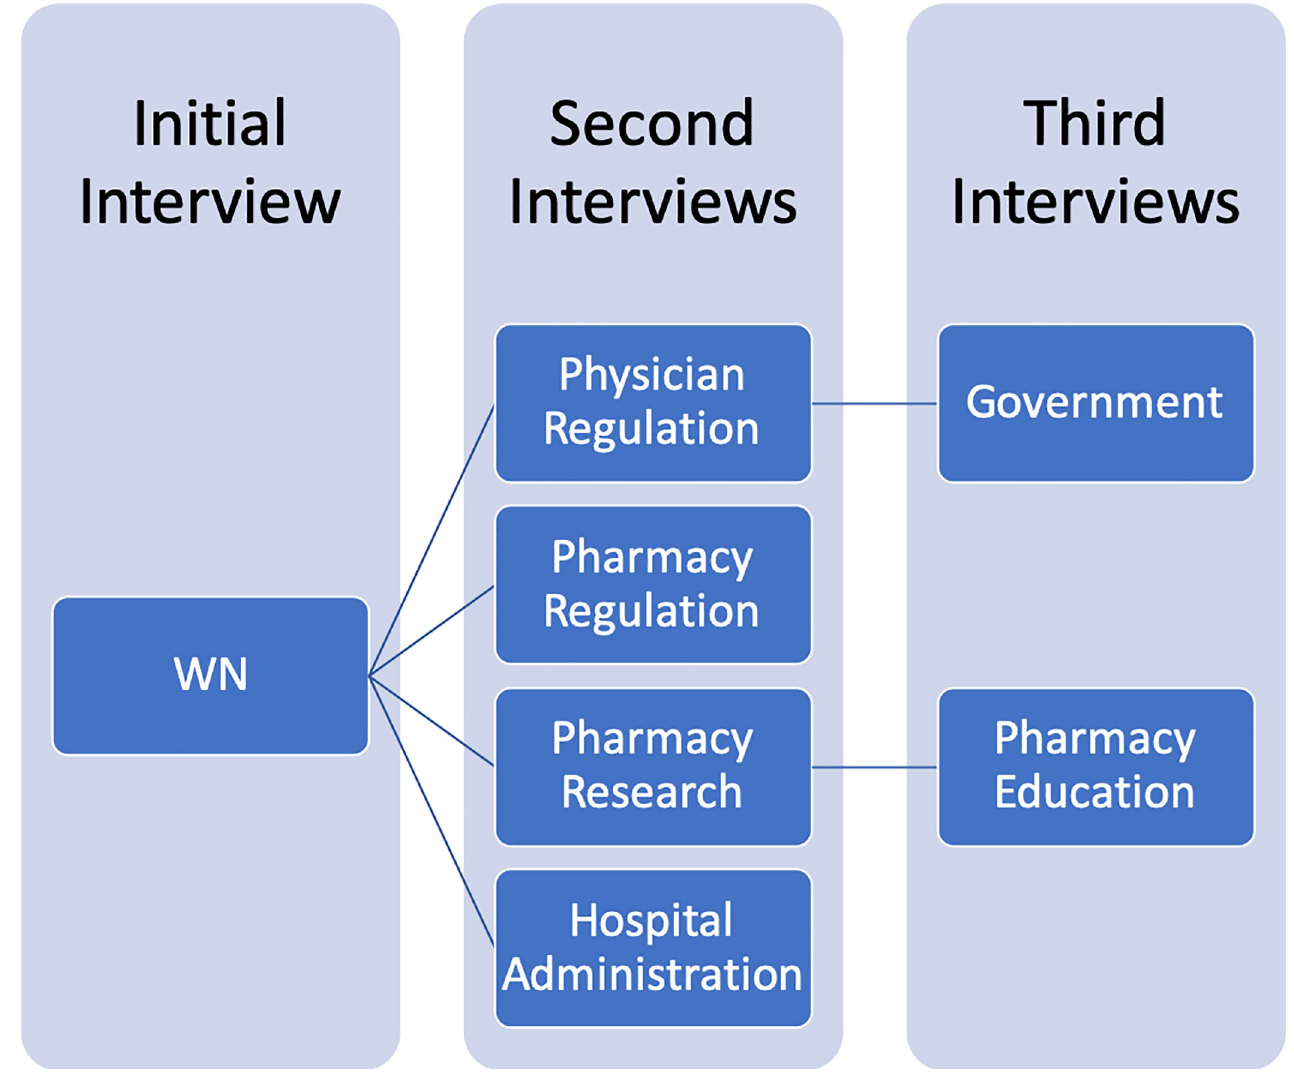
Fig 1. Recruitment timeline.